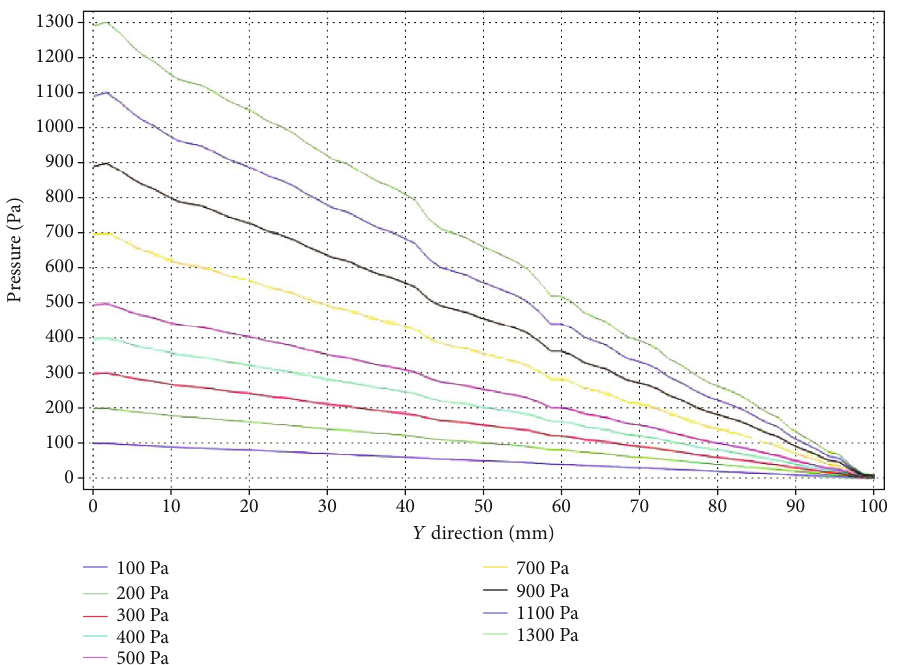
Figure 9: Distribution of seepage pressure on the fracture surface of specimen